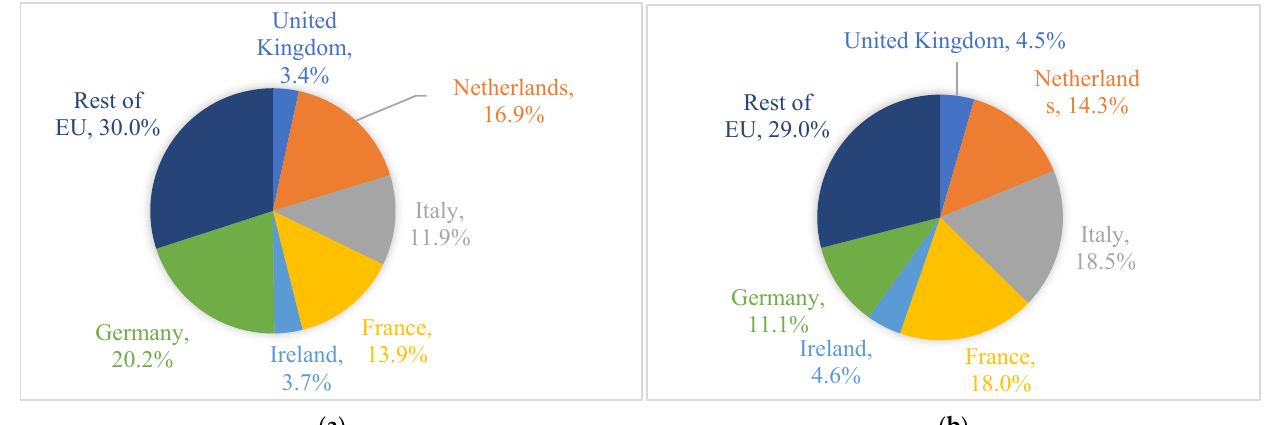
Figure 1. Six studied countries’ cheese export shares in international markets in 2018 (Billion USD). (Source: authors’ depiction using data downloaded from Eurostat database, accessed on 11 August 2019). ( a ) Cheese export shares in the intra-EU market. ( b ) Cheese export shares in the extra-EU